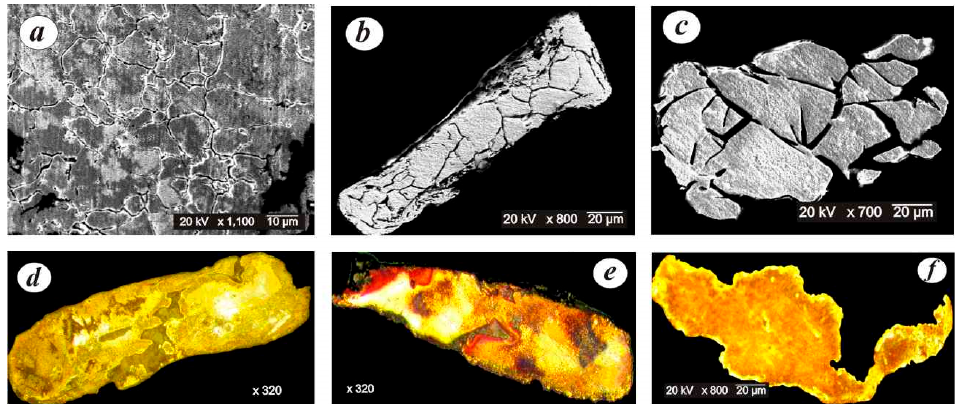
Figure 4. Internal structures of placer gold: ( a ) granulation; ( b , c ) disintegration structures (Dzherba, Bol. Patom rivers); ( d , e ) unclear-zonal structures (Tokko, Torgo rivers); ( f ) thin high-grade shell on low-grade gold (Torgo river).